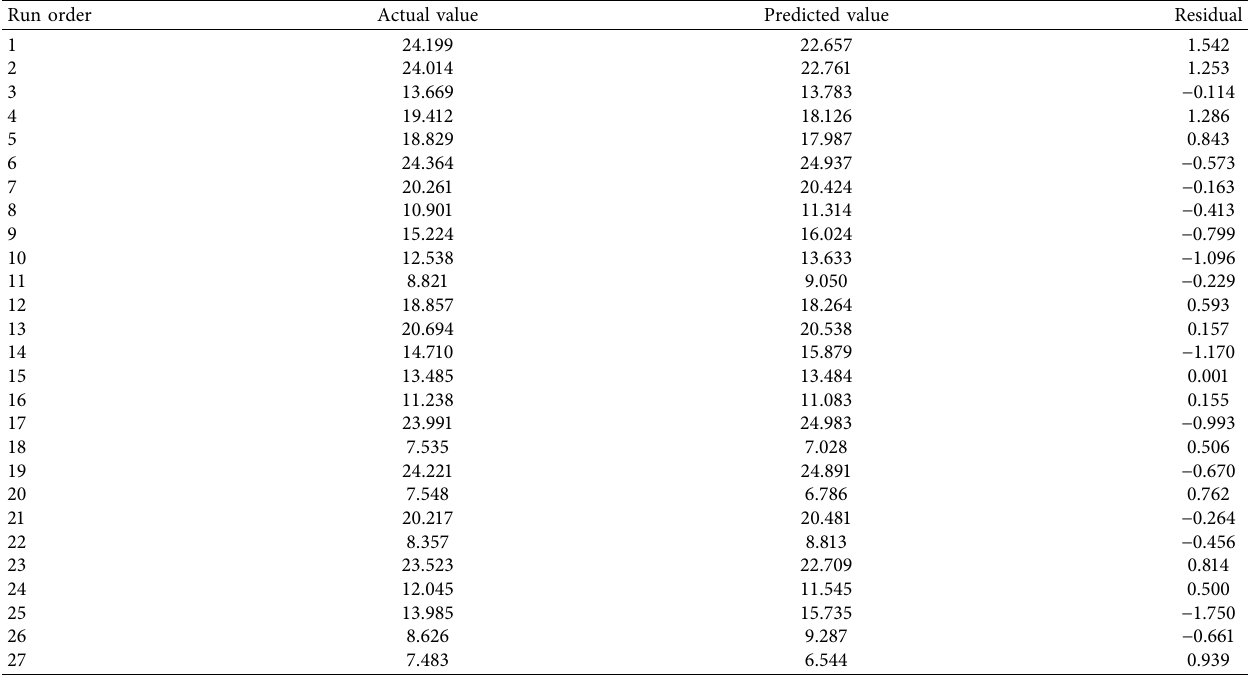
Figure 9: Effect on WF and PT Table 6: Optimization results of